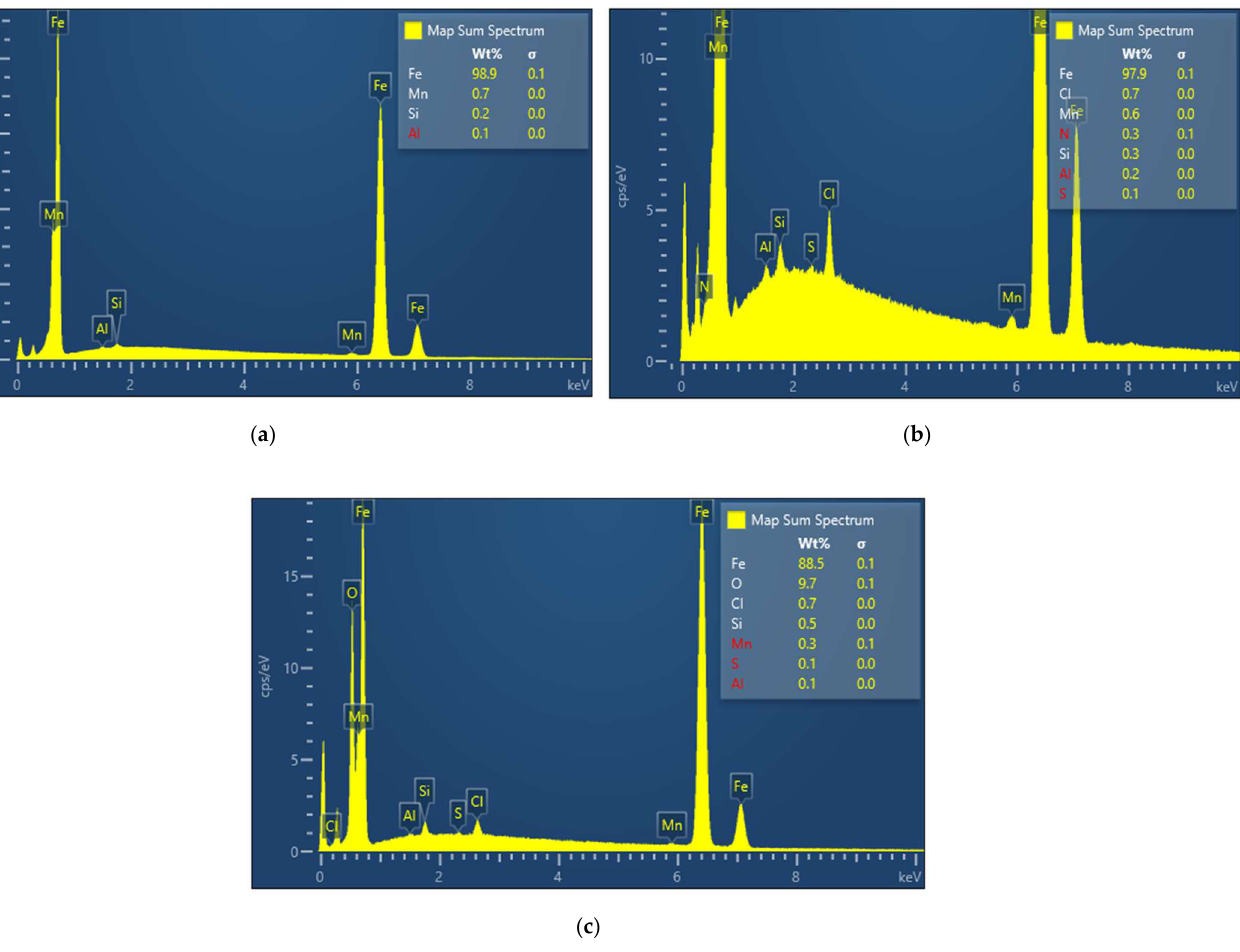
Figure 9. EDX spectra of C-steel surface before ( a ) and after 1 h ( b ) and 12 h ( c ) immersion in 1.0 M HCl solution containing 5 mM PyODT. Table 3. EDX analysis of C-steel surface after different immersion times in 1.0 M HCl solution without and with 5 mM PyODT, as determined from EDX analysis.